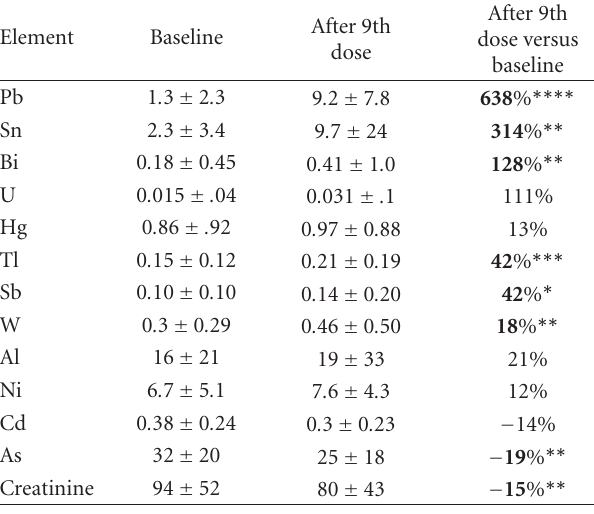
Table 2: Urinary excretion of toxic metals in Phase 1, at baseline and after 9th dose of DMSA, in mcg/g creatinine. Creatinine values have units ofmg/dL. N = 63. The metals are listed in approximate order of e ff ect of DMSA on excretion. Significant results are highlighted in bold font.